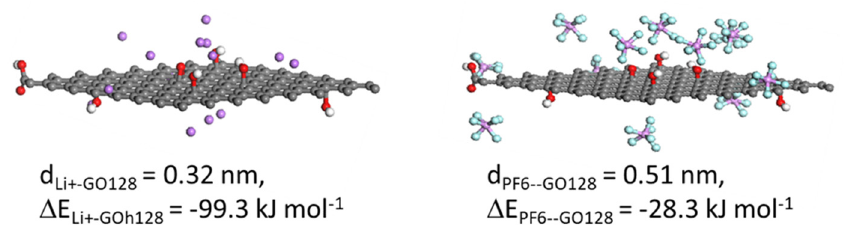
Figure 4. Graphitic oxide sheet with 128 C atoms, GO128 (representing xGNP-750 in this study), coordinated with either the desolvated cation or the desolvated the anion of electrolyte LiPF 6 ; noted the average distance and the adsorption energy between GO128 and the center of ion mass.